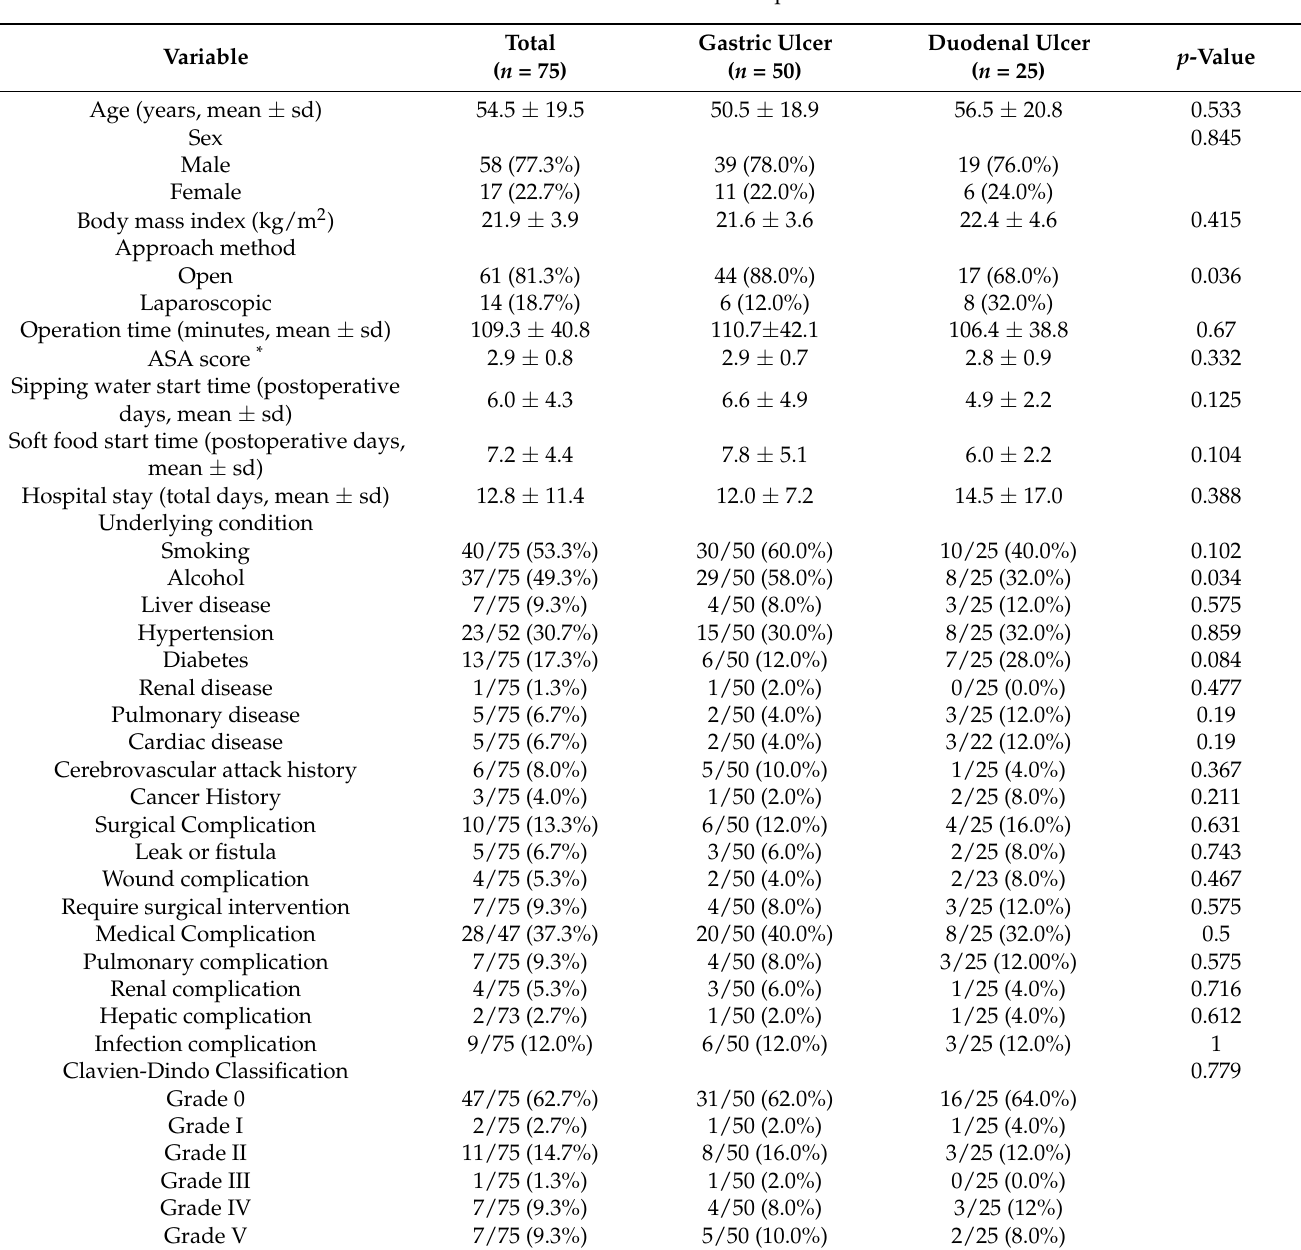
Table 1. Clinical characteristics of